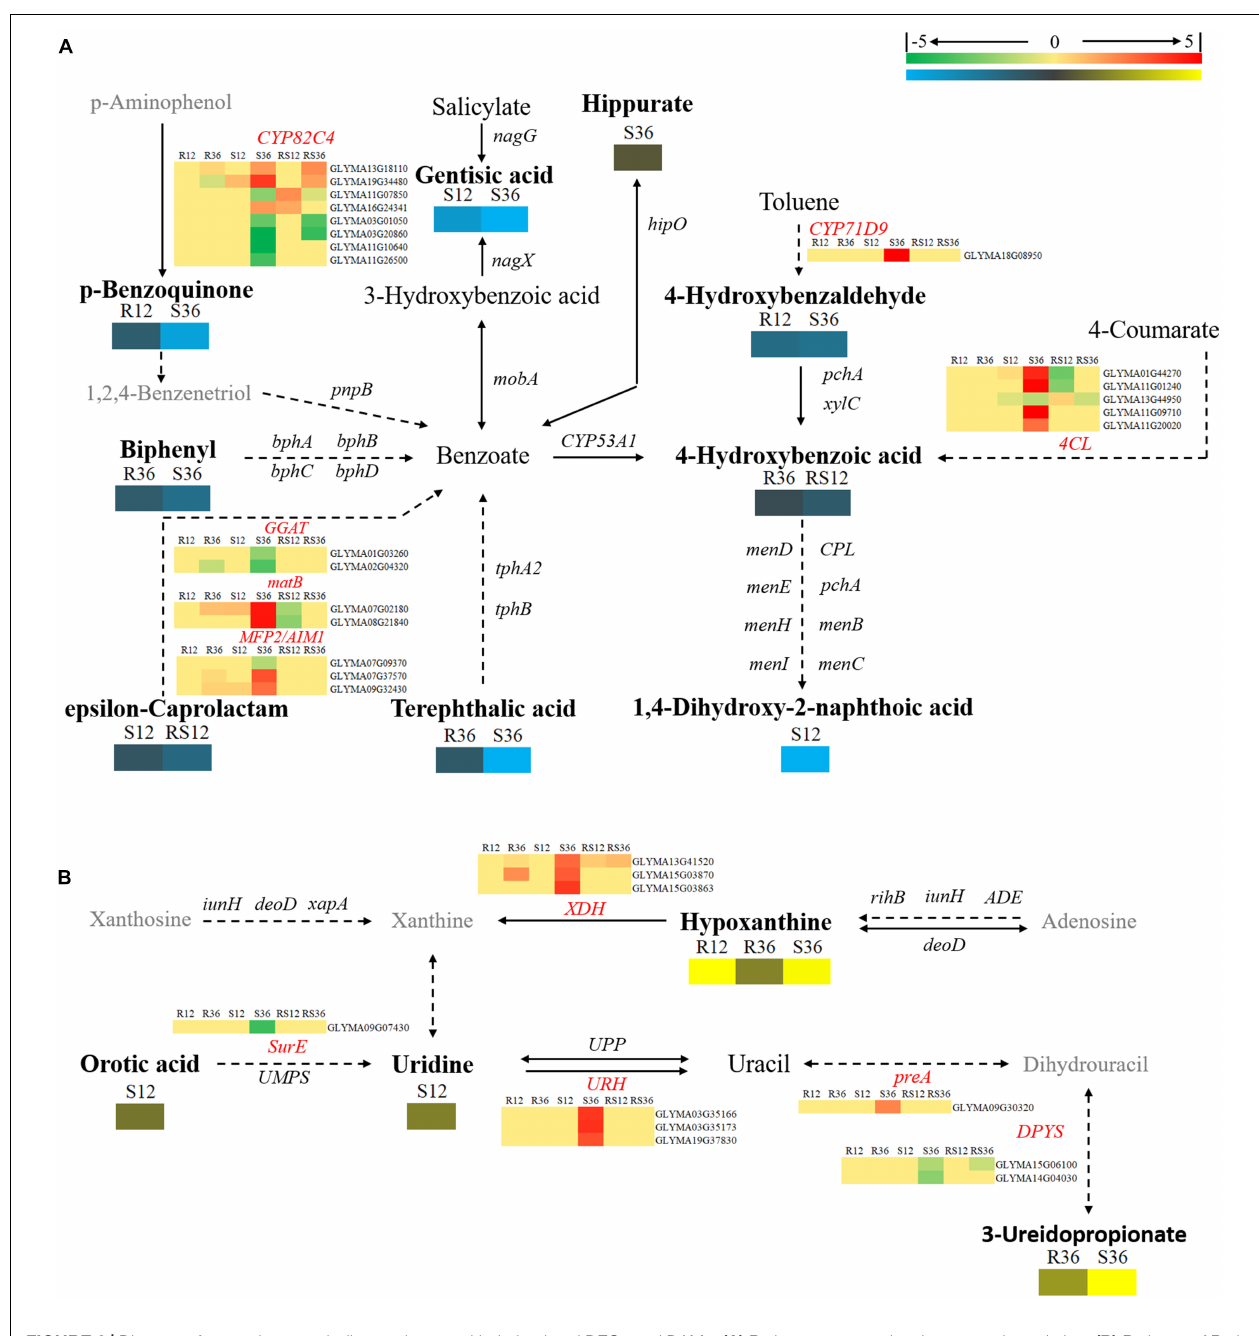
FIGURE 6 | Diagram of secondary metabolism pathways with their related DEGs and DAMs. (A) Pathways centered on benzoate degradation. (B) Pathway of Purine metabolism. DAMs are in bold black fonts. No significantly differentially accumulated metabolites are in black fonts, unidentified metabolites are in gray fonts, and the abbreviations of gene names are in italics. The log 2 Foldchange was colored using Cluster 3.0 (red for upregulated DEGs, green for downregulated DEGs, yellow for upregulated DAMs, and blue for downregulated DAMs), and the vertical columns represent R12, R36, S12, S36, RS12 and RS36, from left to right. R12: R-12h-IN vs. R-12h-CK; R36: R-36h-IN vs. R-36h-CK; S12: S-12h-IN vs. S-12h-CK; S36: S-36h-IN vs. S-36h-CK; RS12: R-12h-CK vs. S-12h-CK; and RS36: R-36h-CK vs. S-36h-CK. IN, inoculated; CK, control check. A color bar is in the upper right corner. Abbreviations of gene names are listed in Supplementary Excel S4